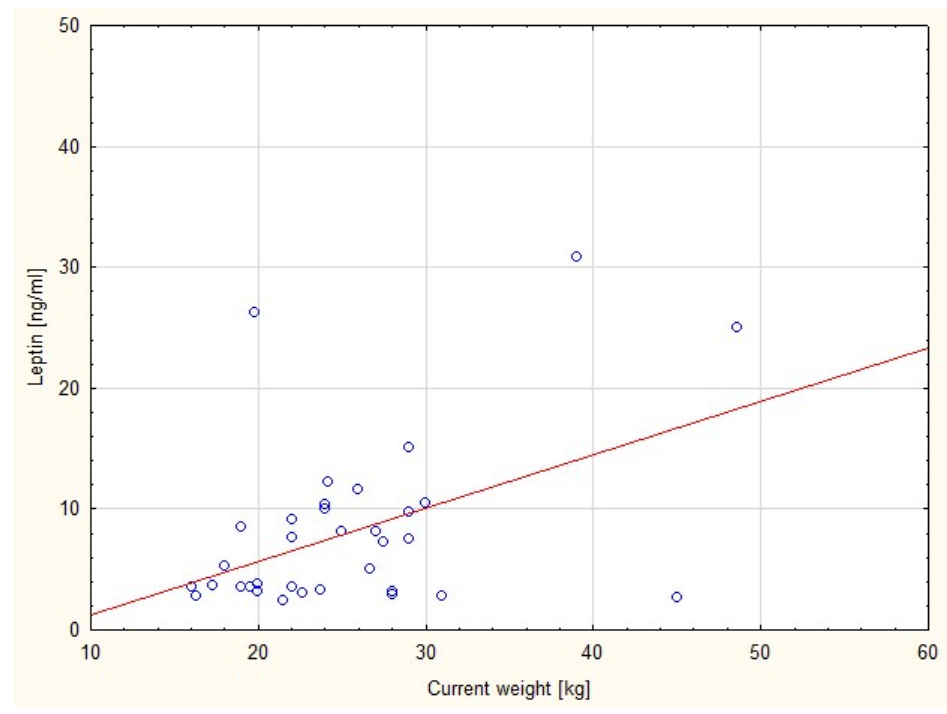
Figure 1. Correlation between serum leptin level and current body weight in SGA